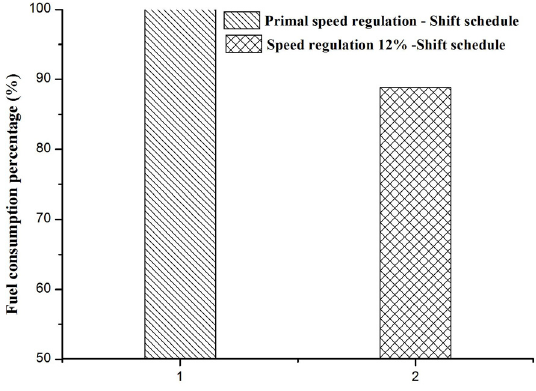
Figure 15. Fuel consumption percentage of real vehicle confirmatory experiment in the smooth driving cycle.